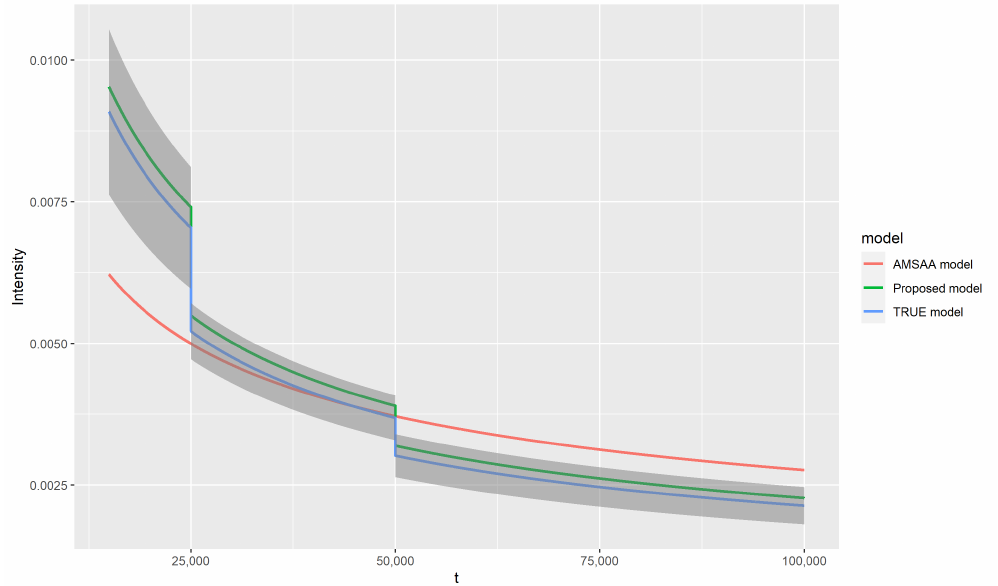
Figure 1. Intensity functions on [ 15,000,100,000 ] in different models. The grey area is the 95% confidence band constructed by the true parameters. For the sake of comparison and neatness, the confidence band is constructed around the true curve rather than the two estimated curves. The band width is the same as that of the proposed model, which is computed with the delta method by plugging in the true parameter